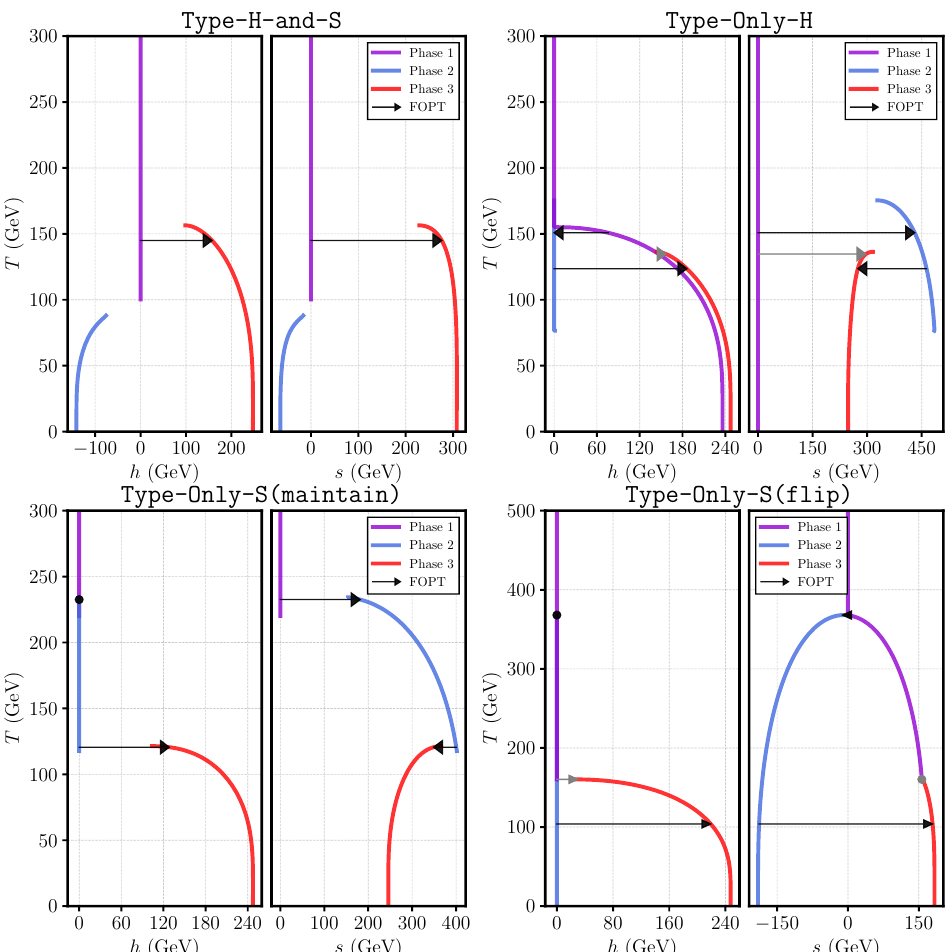
Figure 1 . Phase structures for typical points in the categories Type-H-and-S (upper left), Type- Only-H (upper right), Type-Only-S(maintain) (lower left) and Type-Only-S(flip) (lower right). The lines show the (cid:12)eld values at a particular minimum as a function of temperature. The arrows indicate that at that temperature the two phases linked by the arrows are degenerate and thus that a FOPT could occur in the direction of the arrow. The dots in the lower panels represent transitions that do not change the corresponding (cid:12)eld values. The black arrows and dots show a path that includes the strongest EW FOPT, while the gray ones are not in that